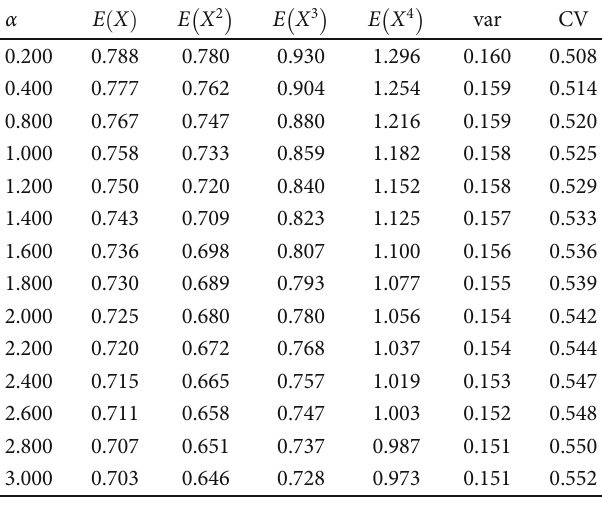
Table 4: Summary statistics of some moments of DWQL distribution at θ = 5 : 0 and various values of α .